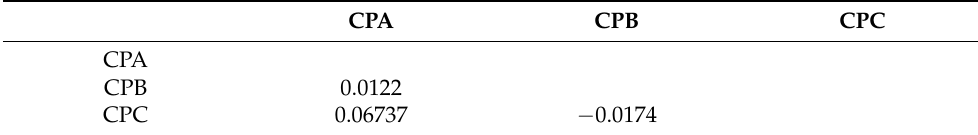
Table 3. Pairwise F ST analysis results for blue